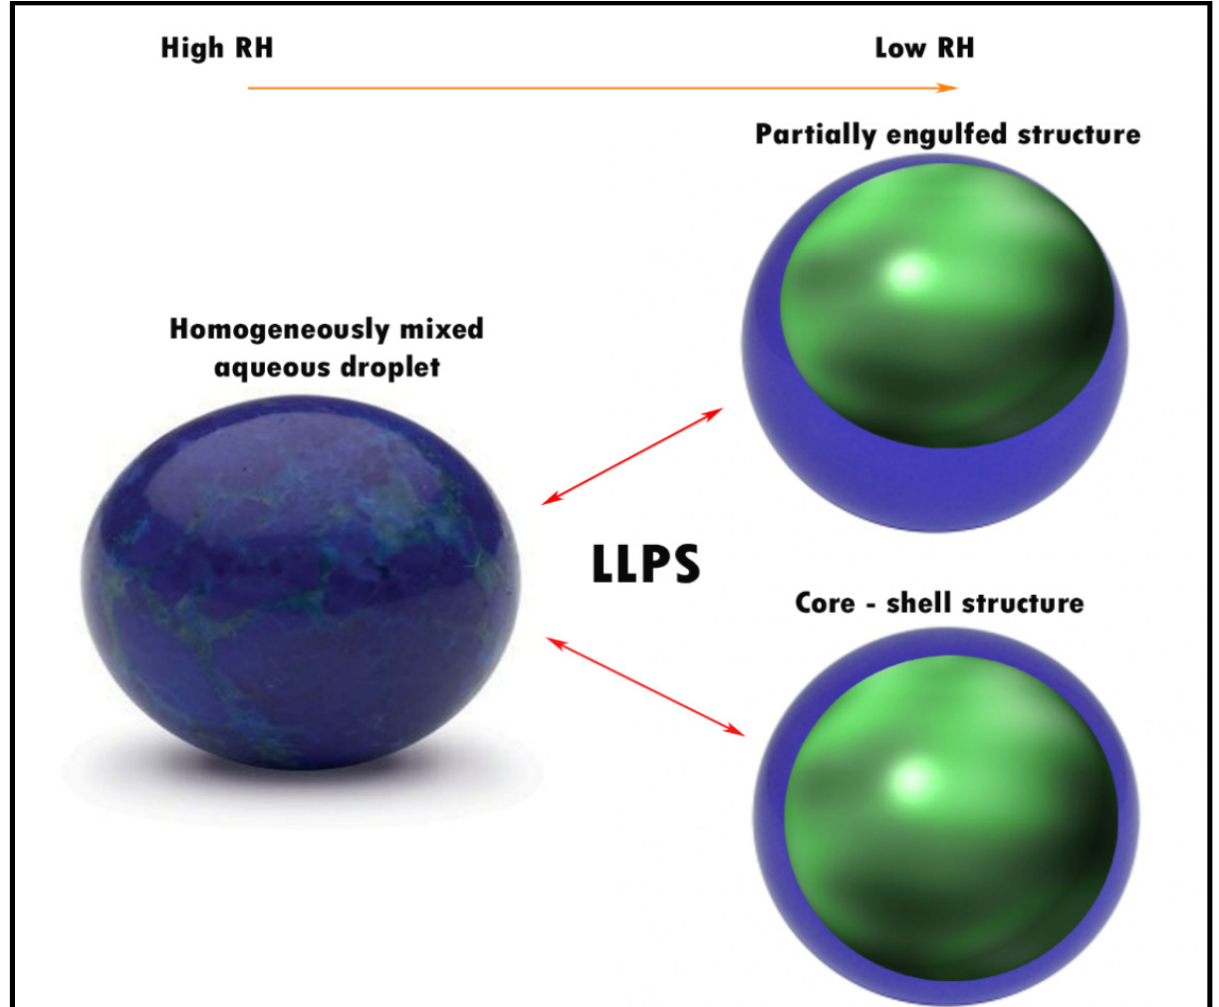
Figure 4. Schematic representation of a homogenously mixed inorganic/organic aerosol droplet un- dergoing liquid – liquid phase separation (LLPS) at varying relative humidity (RH) conditions. undergoing liquid–liquid phase separation (LLPS) at varying relative humidity (RH)